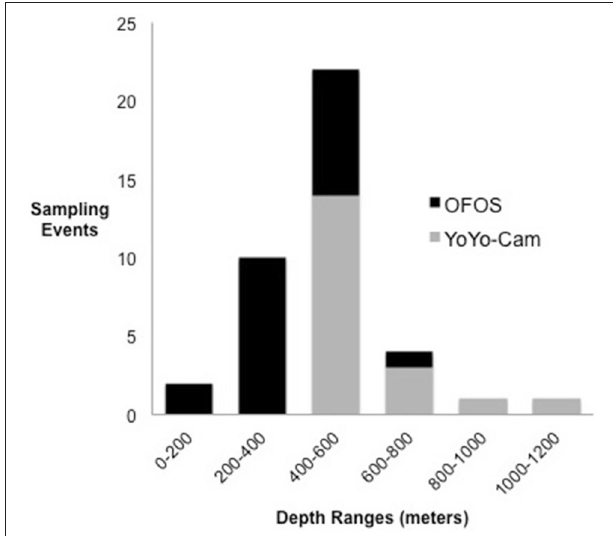
FIGURE 1 | Number and type of imaging survey methods at various depth